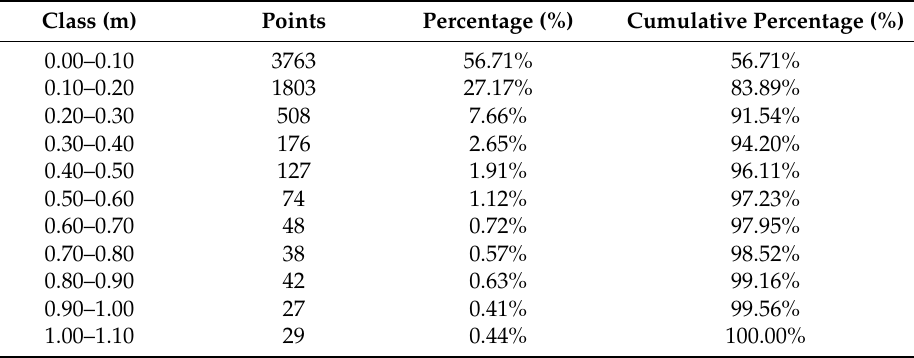
Table 5. Number of points in different layers of overlap